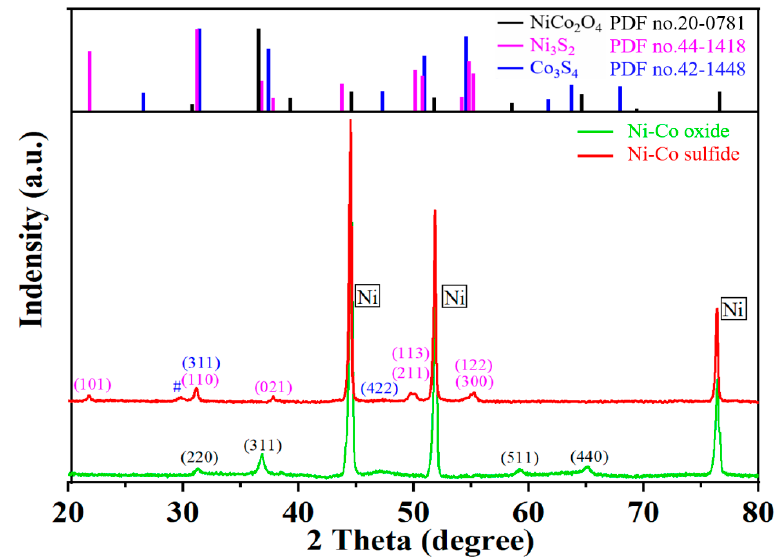
Figure 2. XRD pattern of as prepared Ni-Co sulfide arrays supported on Ni foam.